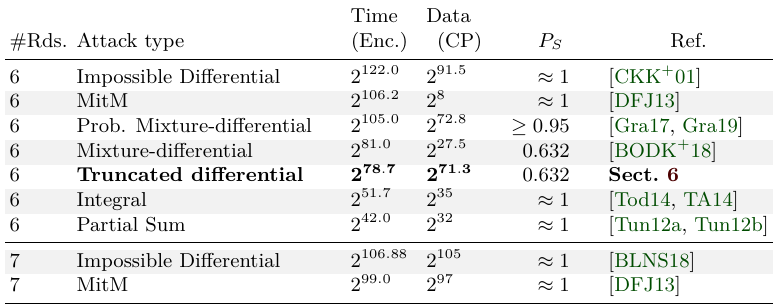
Table 4: Comparison of the best secret-key key-recovery attacks on six-round AES -128 and the best attacks on seven rounds, ordered by rounds (descending) then time (ascending). Enc.